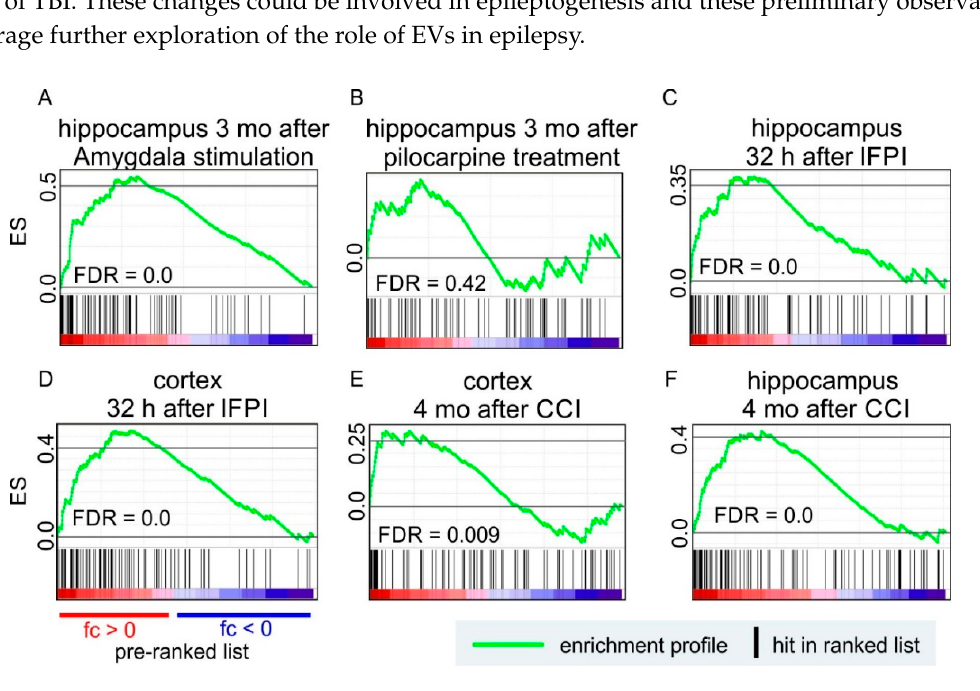
Figure 2. The effect of epileptogenesis and epilepsy on EV-related genes in four rodent models of epileptogenesis: (i) status epilepticus (SE) triggered by electrical stimulation of the amygdala [92]; (ii) SE induced by intraperitoneal injection of a chemoconvulsant, pilocarpine [92]; (iii) traumatic brain injury (TBI)